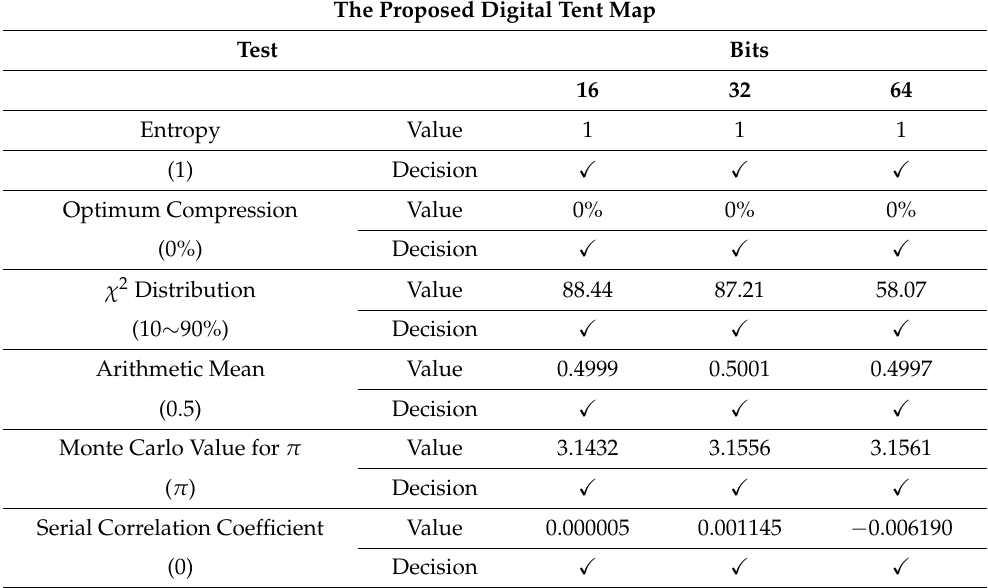
Table 5. The results of the ENT test suite for our digital tent map. The value in brackets is the expected value in each